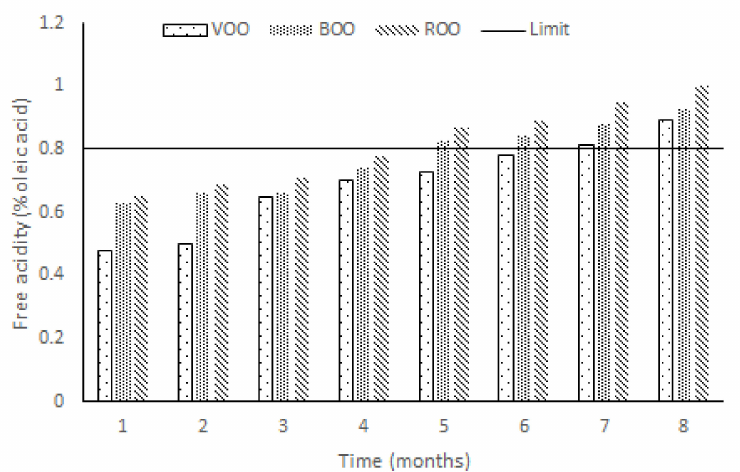
Figure 1. Bar graph for free acidity (FA) of the three samples—virgin olive oil (VOO), virgin olive oil flavoured with basil (BOO), and virgin olive oil flavoured with rosemary (ROO)—during the storage experiment of eight months. The limit of FA for extra virgin olive oils (EVOO) is 0.8%